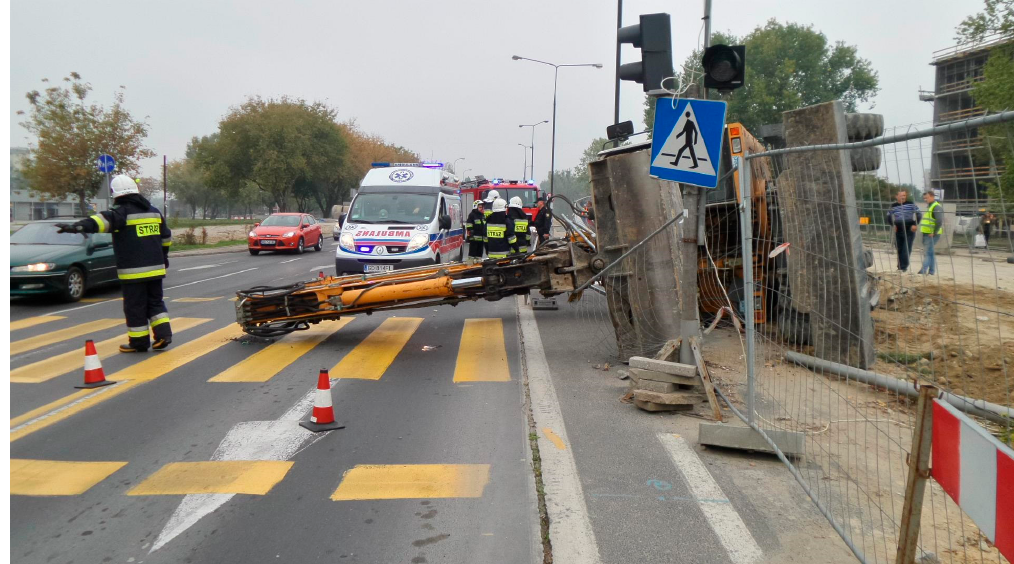
Figure 2. Example of an excavator that overturned onto a pedestrian crossing and hit a passer-by [6].